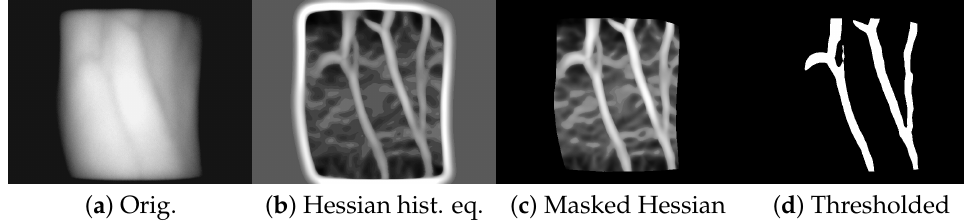
Figure 4. Image segmentation